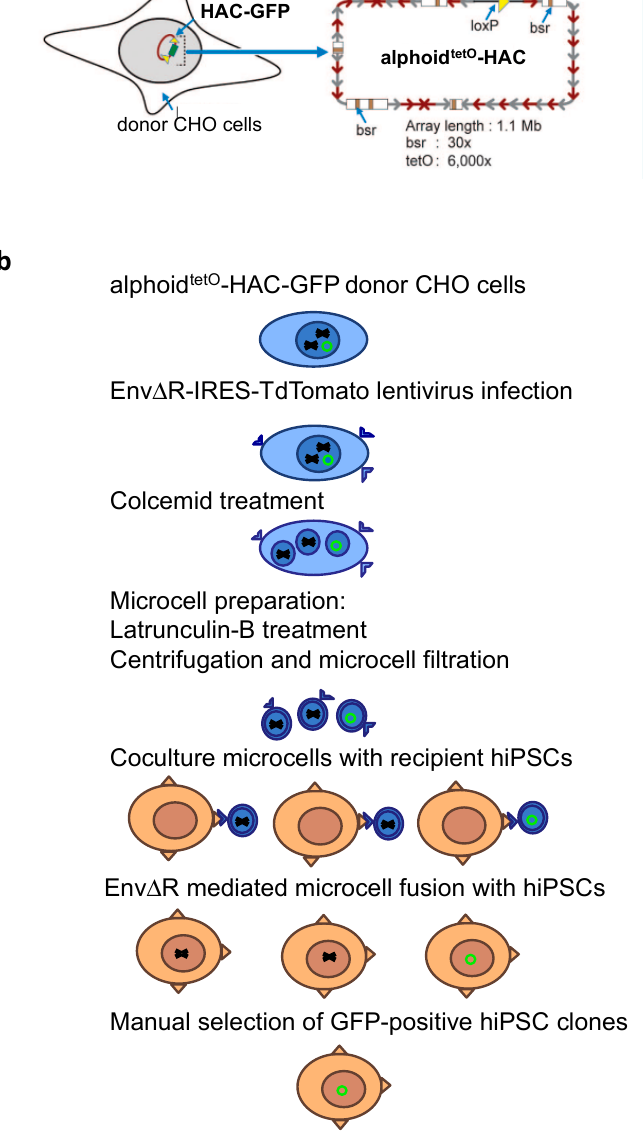
Figure 2. Scheme of microcell mediated chromosome transfer (MMCT) method used in this paper. ( a ) Schematic representation of alphoid tetO -HAC-GFP vector. ( b ) MMCT of the alphoid tetO -HAC-GFP into human pluripotent stem cells (iPSCs) with the use of mouse leukemia virus envelop protein (Env ∆ R) as a cell fusion agent and latrunculin B as a cytoskeleton